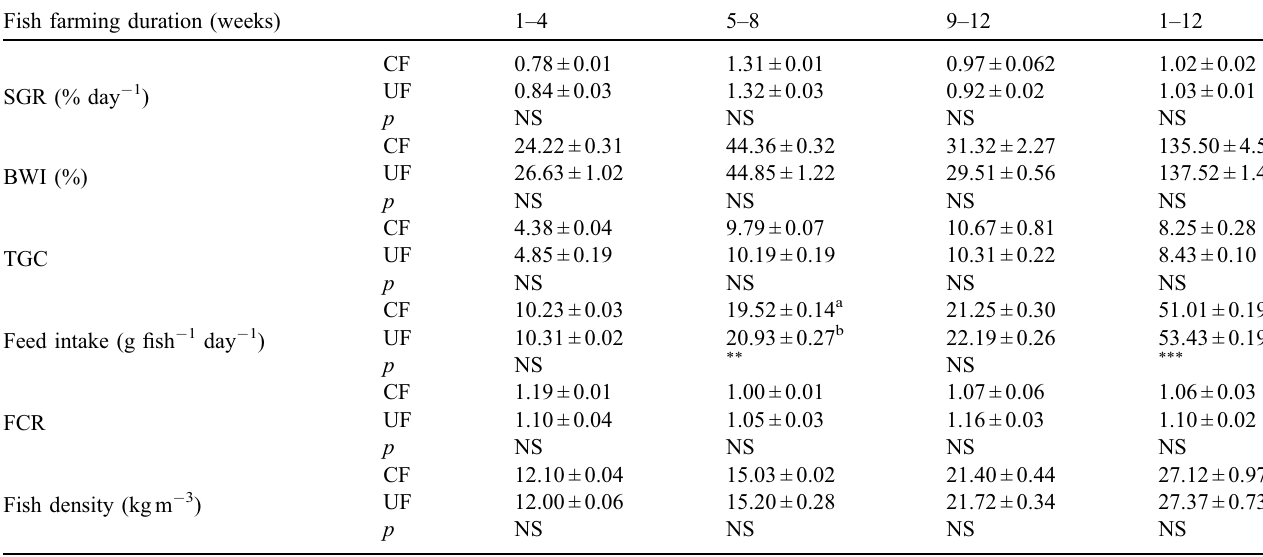
Table 4. Growth performance of sea bass reared in RAS with (UF) or without Ulva (CF) during different time periods of the experiment ( n =3). Fish farming duration (weeks)